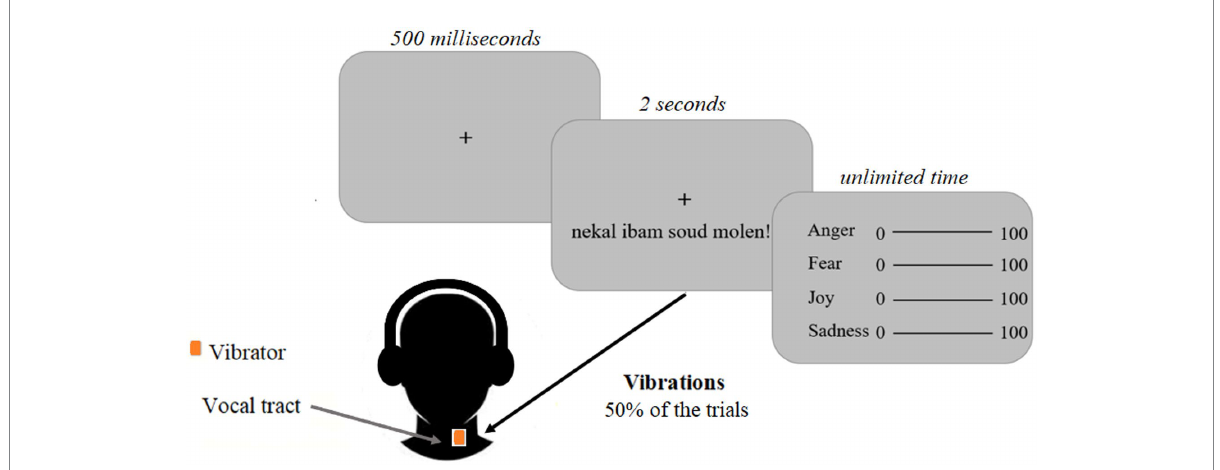
FIGURE 3 Experimental design of Study 1. Participants were instructed to focus on a black central fixation cross displayed on a grey screen for five hundred milliseconds. Emotional voice stimuli were presented through headphones for 2 s. Vibrations were induced at the same time in half of the trials and matched the voice stimuli. The vibrator was located close to the vocal cords. After the voice stimuli, visual analogue scales were displayed indicating that the participants had to evaluate the emotion expressed in the voice stimuli, without time